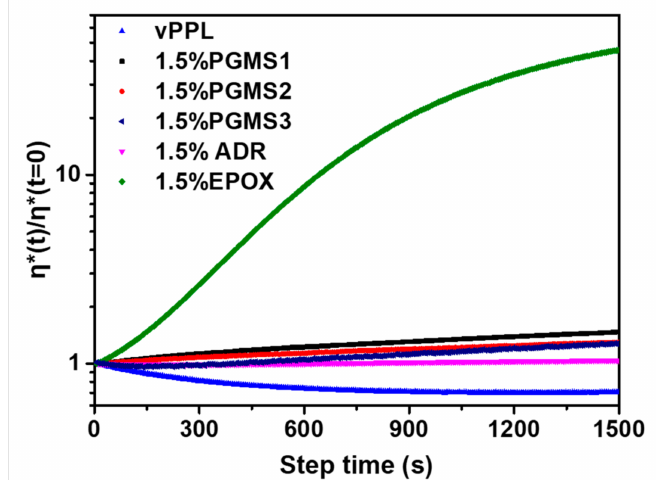
Figure 4. Dynamic time sweeps of various modified